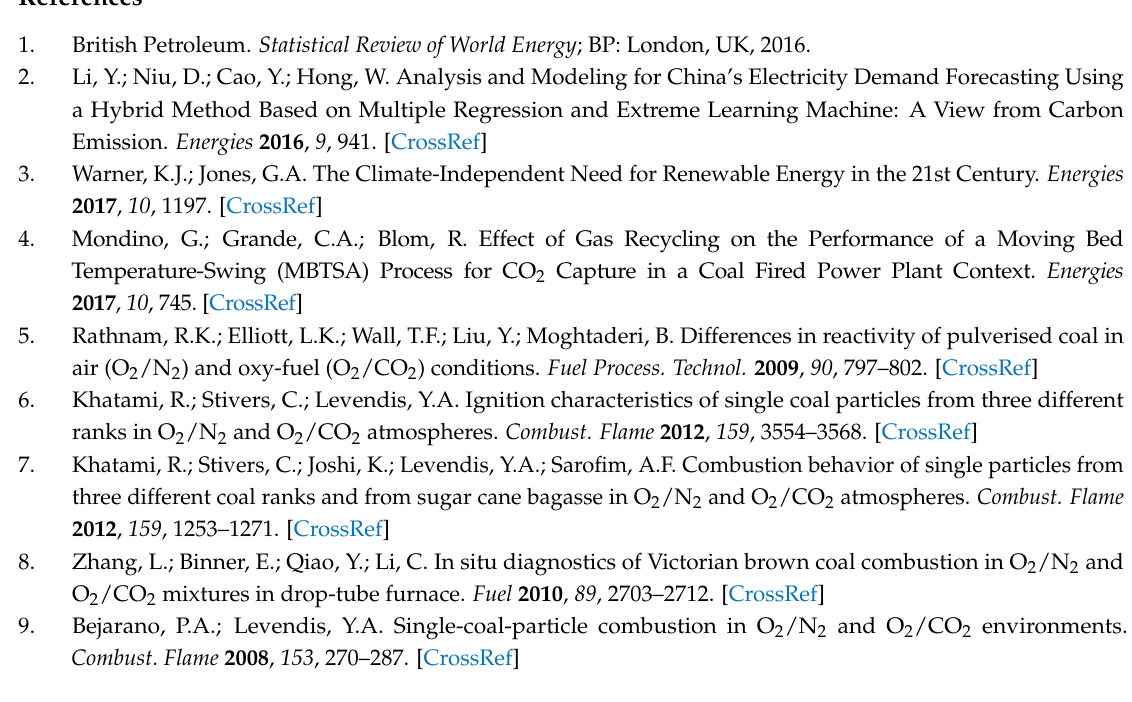
Figure S1: The influences of O 2 mole fraction on the combustion characteristics of BC particles in an O 2 /N 2 atmosphere. (a) BC-21%O 2 + 79%N 2 ; (b) BC-30%O 2 + 70%N 2 ; and (c) BC-40%O 2 + 60%N 2 , Figure S2: The influences of O 2 mole fraction on the combustion characteristics of PS particles in an O 2 /N 2 atmosphere. (a) PS-21%O 2 + 79%N 2 ; (b) PS-30%O 2 + 70%N 2 ; and (c) PS-40%O 2 + 60%N 2 , Figure S3: The influences of O 2 mole fraction on the combustion characteristics of bituminous coal particles in an O 2 /CO 2 atmosphere. (a) BC-21%O 2 + 79%CO 2 ; (b) BC-30%O 2 + 70%CO 2 ; and (c) BC-40%O 2 + 60%CO 2 , Figure S4: The influences of O 2 mole fraction on the combustion characteristics of PS particles in an O 2 /CO 2 atmosphere. (a) PS-21%O 2 + 79%CO 2 ; (b) PS-30%O 2 + 70%CO 2 ; and ( c ) PS-40%O 2 + 60%CO 2